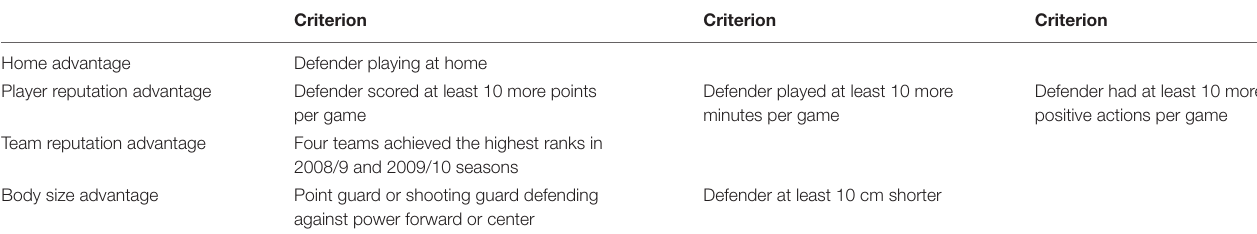
TABLE 1 | Variables used to test for officiating biases in offensive foul situations.